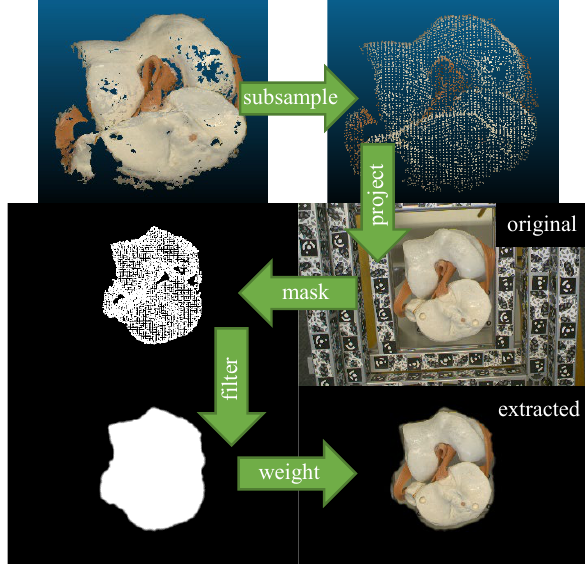
Figure 8. Knee joint extraction from 3D point cloud. A rough cloud is computed by two image triples, subsampled and projected into one original image. The projected points are coloured white as a mask. The mask is closed and blurred at the edges before used as a weighting function to extract only the knee joint of the original image.